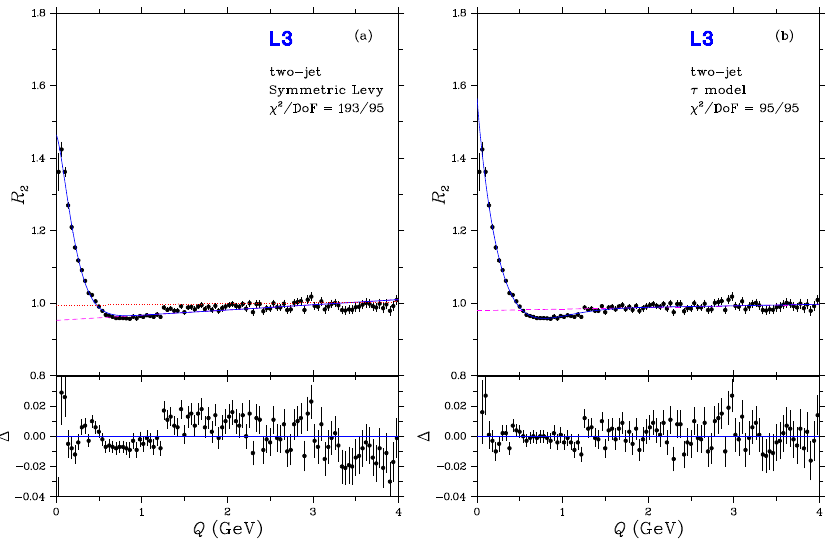
Figure 1. (a) Symmetric Lévy fit for two-jet events; (b) Simplified τ -model fit for two-jet